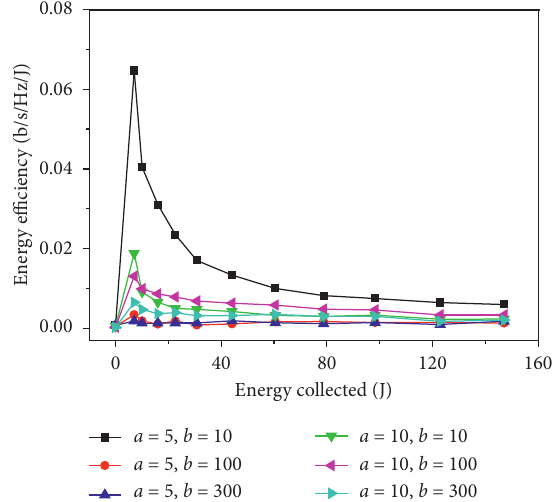
Figure 5: The IoT energy efficiency results achieved by the pro- posed scheme when ρ � 0.5.